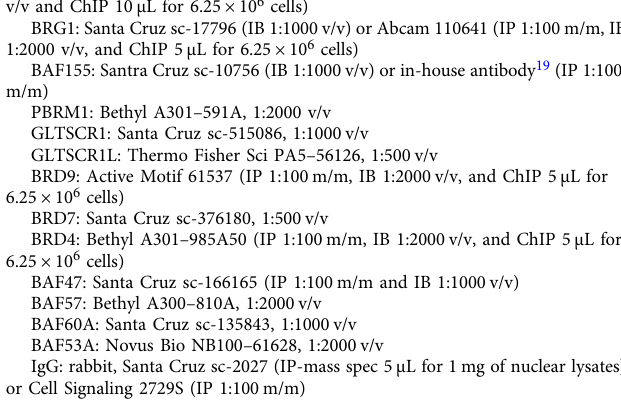
The next day, 0.5 mL fractions were collected and analyzed using immunoblotting (IB).